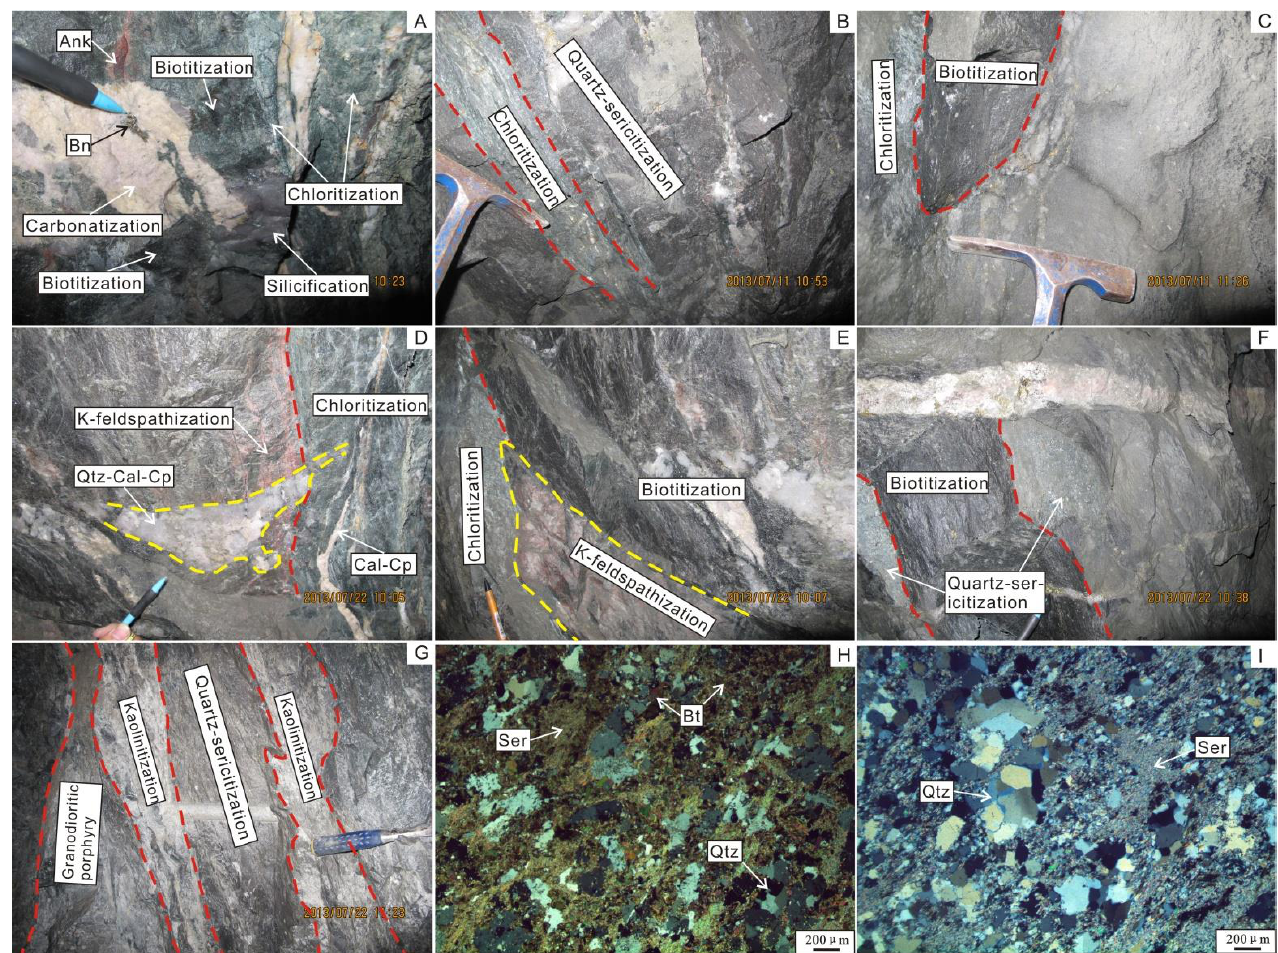
Figure 4. Different alteration types in the Tongkuangyu deposit. ( A ) Chloritization, biotitization, silication, and carbonatization in biotite schist (Sample 1381, No. 5147 tunnel of No. V orebody on 690-m level). ( B ) Chloritization and quartz–sericitization in quartz–sericite schist (Sample 1569, No. 4143 tunnel of No. IV orebody on 530-m level). ( C ) Chloritization and biotitization in biotite schist (Sample 1604, No. 4143 tunnel of No. IV orebody on 530-m level). ( D ) K–feldsparization and chloritization crosscut by quartz–calcite–chalcopyrite vein. Quartz–calcite–chalcopyrite vein cut by calcite–chalcopyrite vein within chloritization zone (Sample 2599, No. 5147 tunnel of No. V orebody on 690-m level). ( E ) Chloritization, biotitization and K feldspathization in biotite schist (Sample 2603, No. 5147 tunnel of No. V orebody on 690-m level). ( F ) Quartz–sericitization along biotitization zone (Sample 2633, No. 4143 tunnel of No. IV orebody on 530-m level). ( G ) Quartz–sericitization and kaolinizitation in the contact zone between granodiorite porphyry and quartz–sericite schist (Sample 2643, No. 4143 tunnel of No. IV orebody on 530-m level). ( H ) Biotite schist (sample 5147–3–2); cross-polarized light. ( I ) Quartz–sericite schist (sample 5147–20); cross-polarized light. Abbreviations: Qtz: quartz; Bt: biotite; Ser: sericite; and Bn: